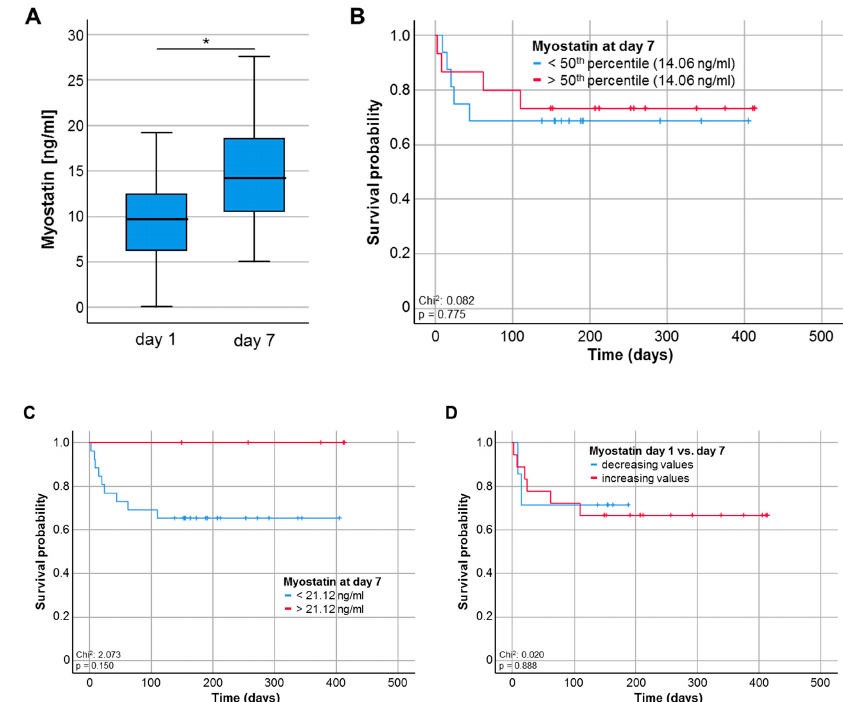
Figure 4. Myostatin serum levels during the course of critical illness. ( A ) Myostatin serum levels are significantly higher at day 7 following ICU admission compared to the respective levels at day 1, * p < 0.05. ( B , C ) Patients with Myostatin serum levels below the 50th percentile (14.06 ng / mL) or the ideal prognostic cut-o ff value (21.12 ng / ml) at day 7 following ICU admission show a trend towards an impaired OS ( p = 0.150). ( D ) ICU patients with increasing or decreasing Myostatin levels between day 1 and 7 have a comparable OS (Figure